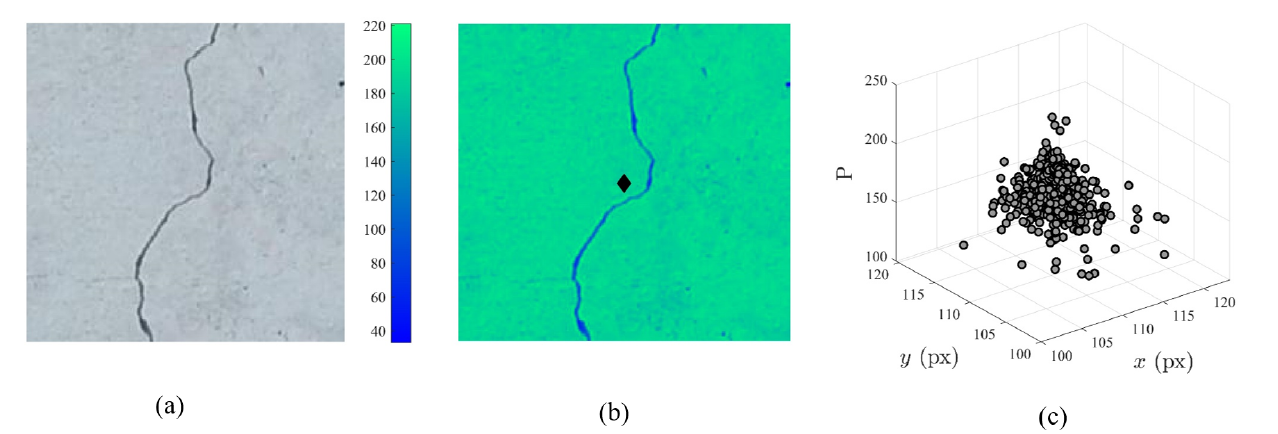
Figure 2. ( a ) Sample training image of concrete crack, ( b ) centroid location (black) based on pixel intensity, and ( c ) centroid location of all images within the ‘crack’ training